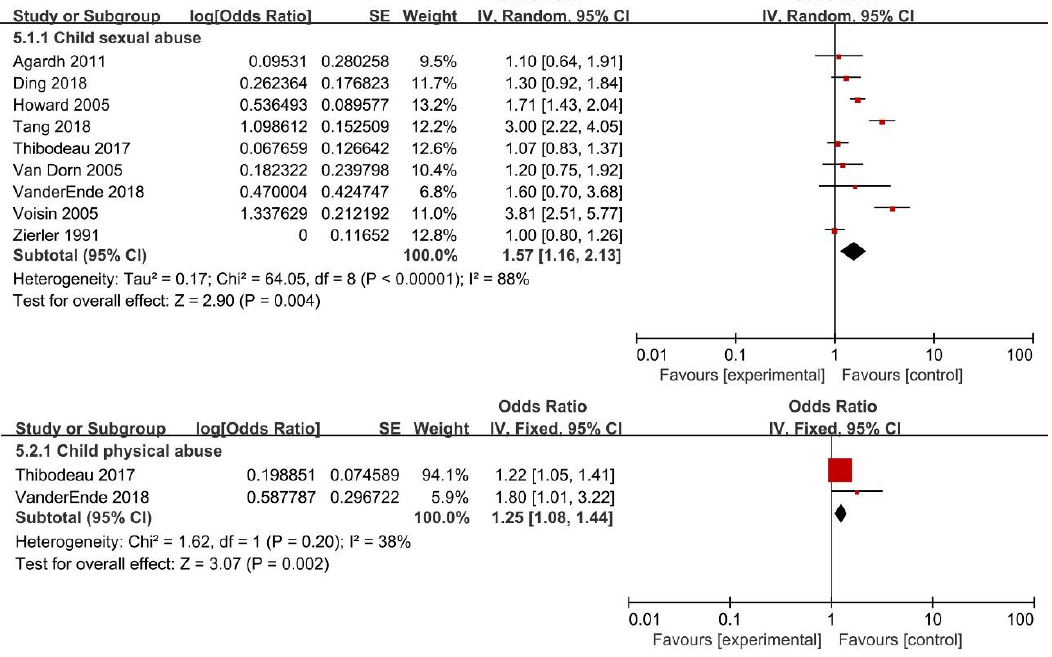
Figure 6. Forest plot for subtypes of childhood maltreatment and risk of having unprotected sex.